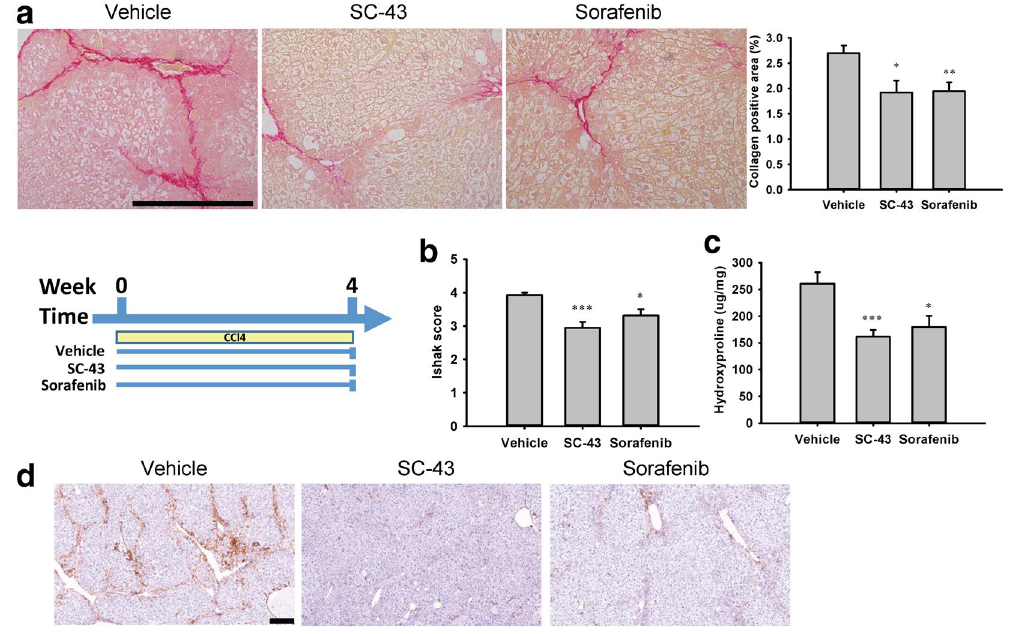
Figure 2. SC-43 treatment ameliorates liver fibrosis in the CCl 4 -induced liver fibrosis mouse prevention model. In the fibrosis prevention model, SC-43 (10 mg/kg) and sorafenib (10 mg/kg) were concurrently administered with CCl 4 for 4 weeks, and significant fibrosis regression was observed. ( a ) Representative images after sirius red staining with the collagen positive area quantification. ( b ) Ishak fibrosis score. ( c ) Liver hydroxyproline quantification. ( d ) α -SMA staining. Scale bar: 200 μ m. No significant difference between SC-43 and sorafenib group. Columns: mean and bars: standard error. * P < 0.05, ** P < 0.01, and *** P < 0.001 compared with the vehicle group. N = 7–9 in each